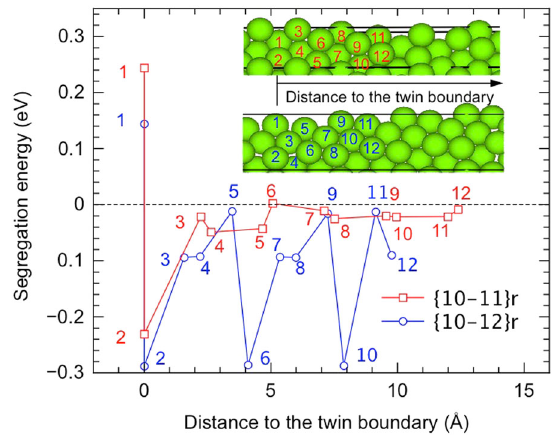
Fig. 5 Segregation energies of one yttrium atom in the vicinity of re fl ection TBs of f 1011 gh 1012 i and f 1012 gh 1011 i twinning in Mg. The initial solute sites in f 1011 gh 1012 i twin are in red , while in the other twin they are in blue in the inset. To differentiate twins of glide and re fl ection variants, subscript “ r ” is introduced to represent the re fl ection twin. Twelve sites are selected (i.e., two sites in the TBs and ten other sites away from the boundaries) to inspect the stability of re fl ection TBs. For all twelve con fi gurations, there is no transforma- tion from re fl ection TBs to glide TBs being atom is introduced into the re fl ection TBs no transformation from re fl ection TBs to glide TBs is observed (see Fig. 5). This information indicates that the re fl ection TBs are more stable than glide TBs when solutes are present. Since solutes may change the potential energy surface and thus be responsible for the instability instead of triggering a motion away from the saddle point only, we need further information to identify the intrinsic stability of glide and re fl ection TBs.